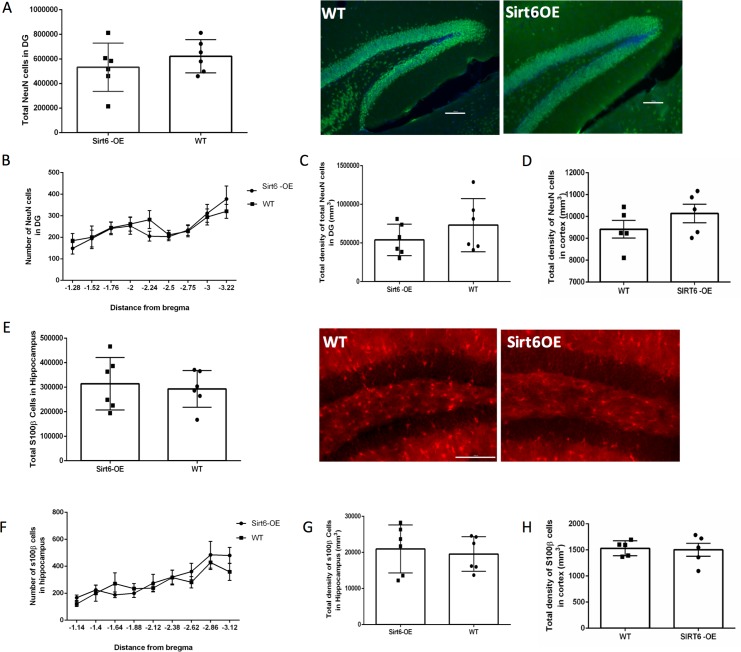
Sirt6-OE does not affect total numbers of DG and cortical NeuN+ or hippocampal and cortical S100β+ cells.(A) Left panel: Total numbers of NeuN+ cells were counted in the DG of WT (n = 6) and Sirt6-OE (n = 6) mice. Right panel: representative NeuN+ cells in the DG. Scale bar = 100μm (B) DG distribution of NeuN+ cells throughout the DG (C) Density of NeuN+ cells in the DG. (D) Density of NeuN+ cells in the cortex. (E) Left panel: Total numbers of S100β+ cells were counted in the hippocampi of WT (n = 6) and Sirt6-OE (n = 6) mice. Right panel: arrow indicates representative S100β+ cells in the hippocampus. Scale bar = 100μm (F) Hippocampal distribution of S100β+ cells. (G) Density of S100β+ cells in the hippocampus. () Density of S100β+ cells in the in the lateral parietal association cortex (LPtA) and primary somatosensory trunk cortex (S1Tr).